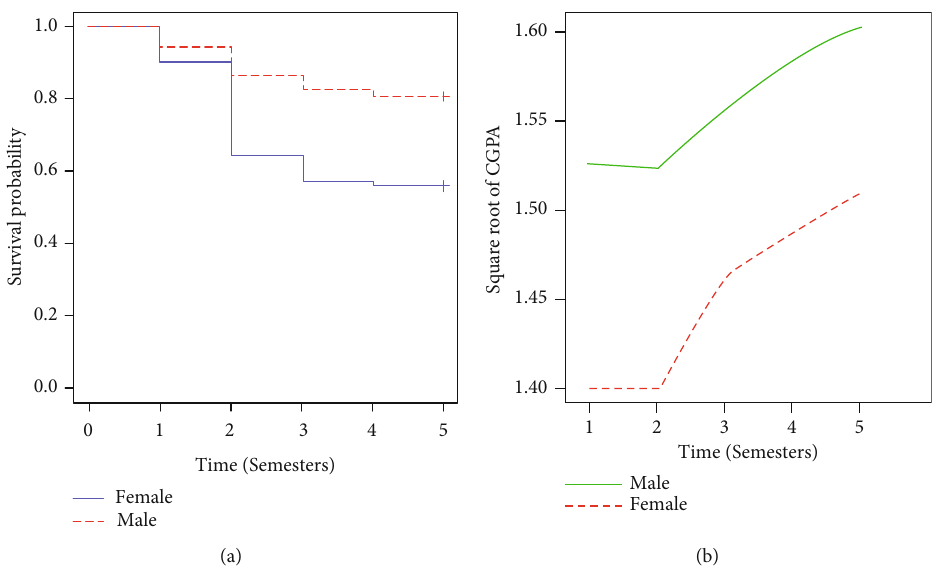
Figure 1: Explanatory data analysis. (a) Kaplan-Meier survival plots. (b) Mean pro fi le